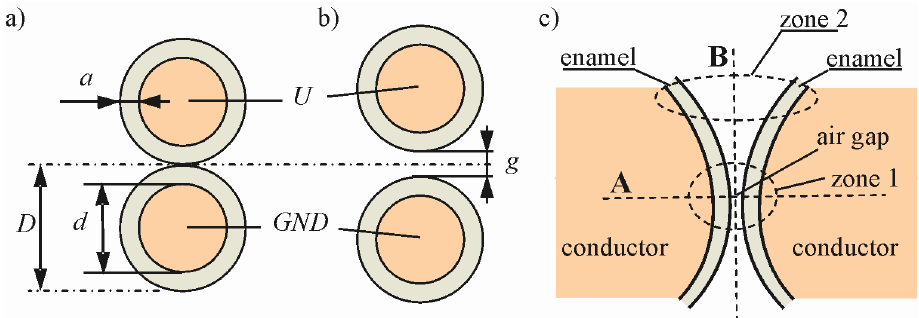
Figure 10. Simplified geometry of the possible mutual position of two magnet wires in a TP sample (without maintaining the scale of insulation thickness in relation to wire diameter): ( a ) microgap g = 0; ( b ) microgap g > 0; ( c ) location of specific zones in the insulation of adjacent winding wires.